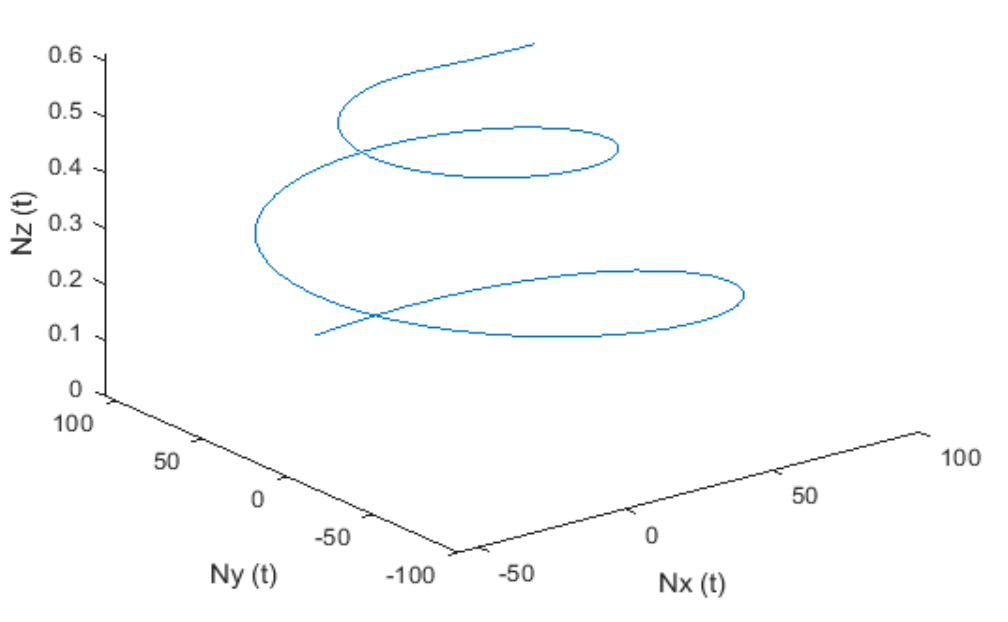
Figure 9. Numerical solutions of the Bloch equation with parameters: α = 1.0, β = 0.9, γ = 0.8, w 0 = 12, T 1 = 1, T 2 = 20, a = 1, b = 1.